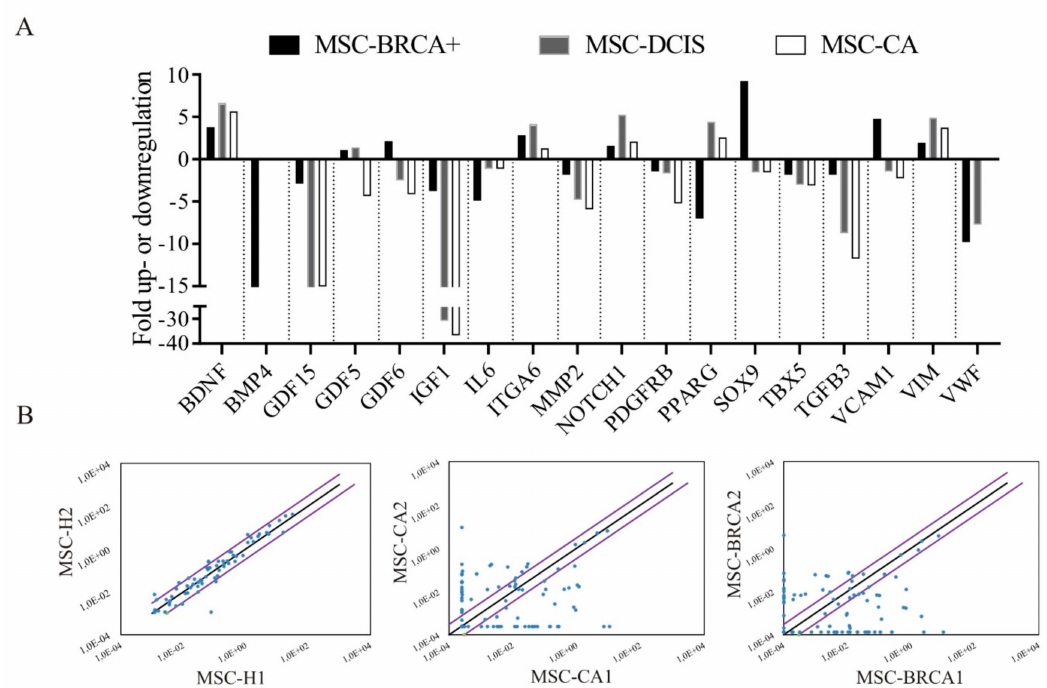
Figure 4. Expression profiles of healthy and cancer patient adipose tissue-derived MSCs. ( A ) RT 2 Profiler ™ PCR human mesenchymal stem cells array of individual MSC isolates used in in vivo study revealed several gene expression changes. ( B ) Scatter plot of mesenchymal stem cell gene expression at the mRNA level comparing two di ff erent healthy (left), cancer (middle) and BRCA + isolates (right). Lateral diagonal lines indicate a 2-fold increase or decrease. Results were obtained using the RT2 Profiler PCR Array Data Analysis software (at Qiagen data analysis web portal). MSCs used for analysis did not exceed 10th